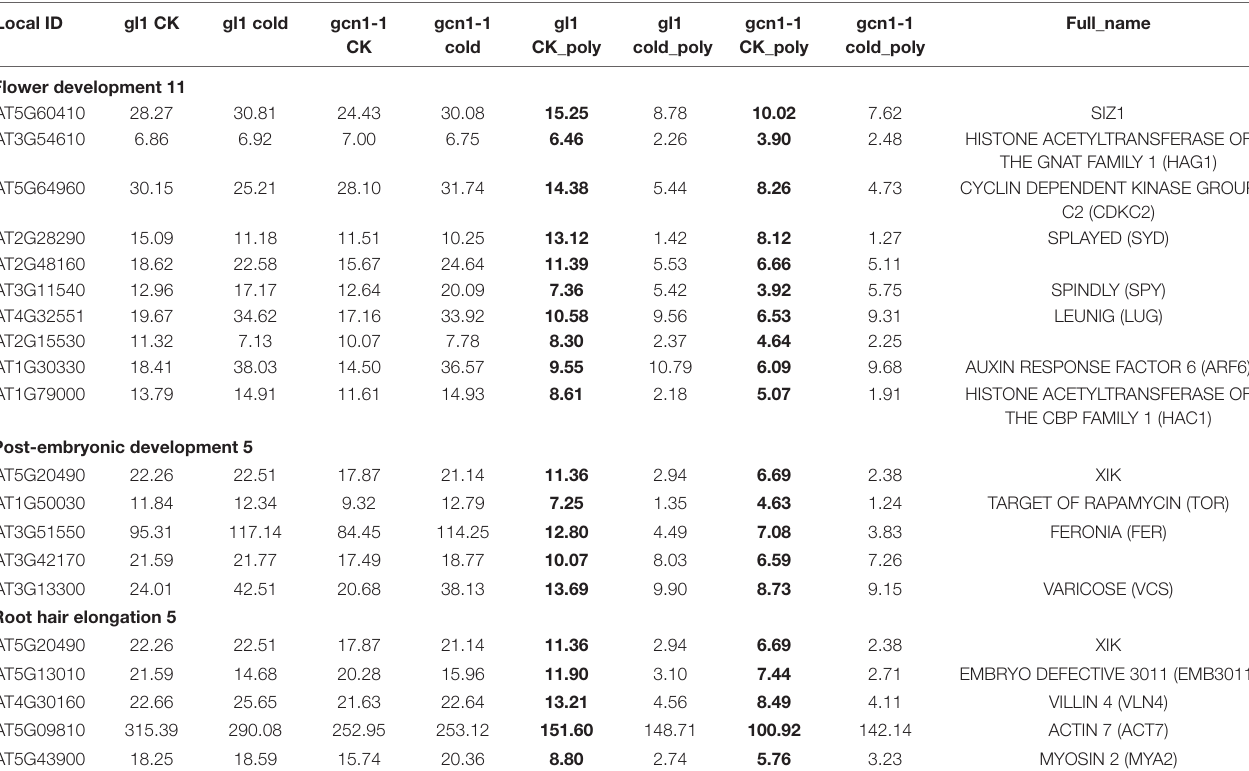
TABLE 8 | Partial Classification data of down-translated genes in atgcn1-1 , compared with that in WT under temperature conditions. Local ID